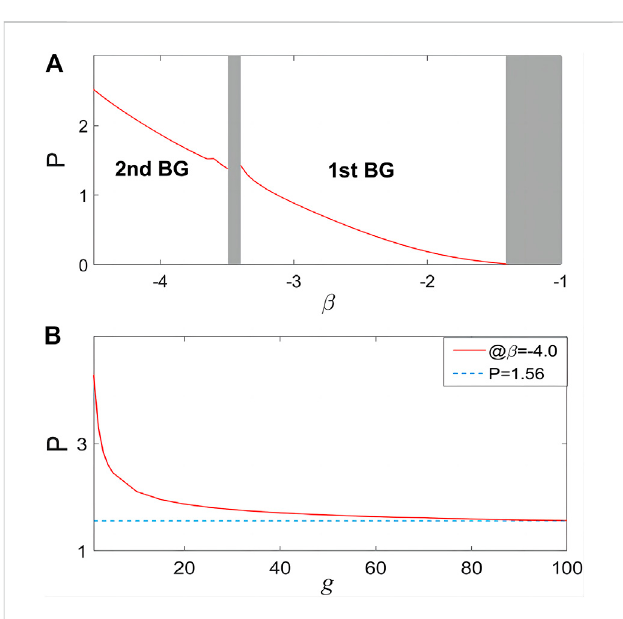
FIGURE 4 (Color online) Power of localized modes versus the associated propagation constant (A) and nonlinear coef fi cient ratio (B) . (A) Nonlinear coef fi cient ratio m (cid:1) 20. (B) Propagation constant β (cid:1) − 4 .